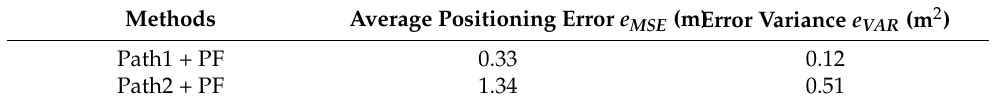
Table 5. The localization effects of using RS method and particle filter (RS-PF).